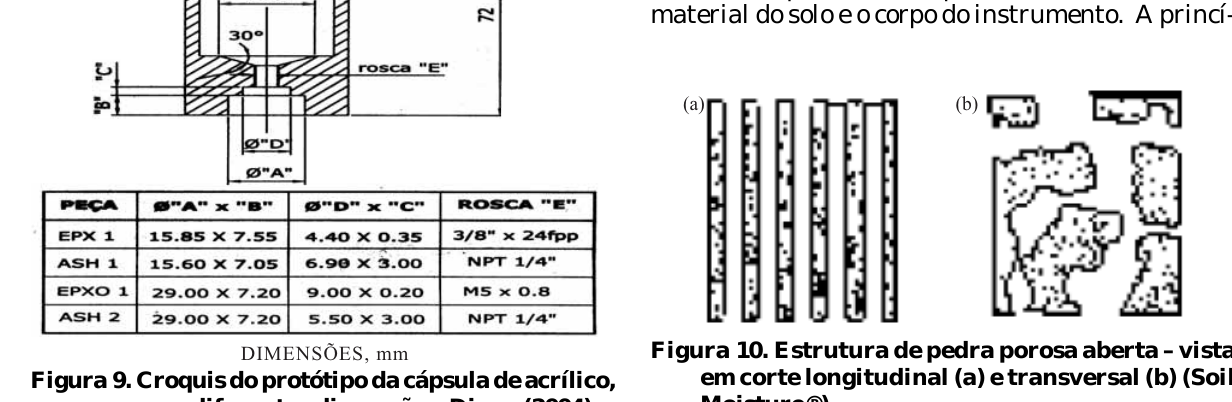
Figura 10. Estrutura de pedra porosa aberta – vista em corte longitudinal (a) e transversal (b) (Soil